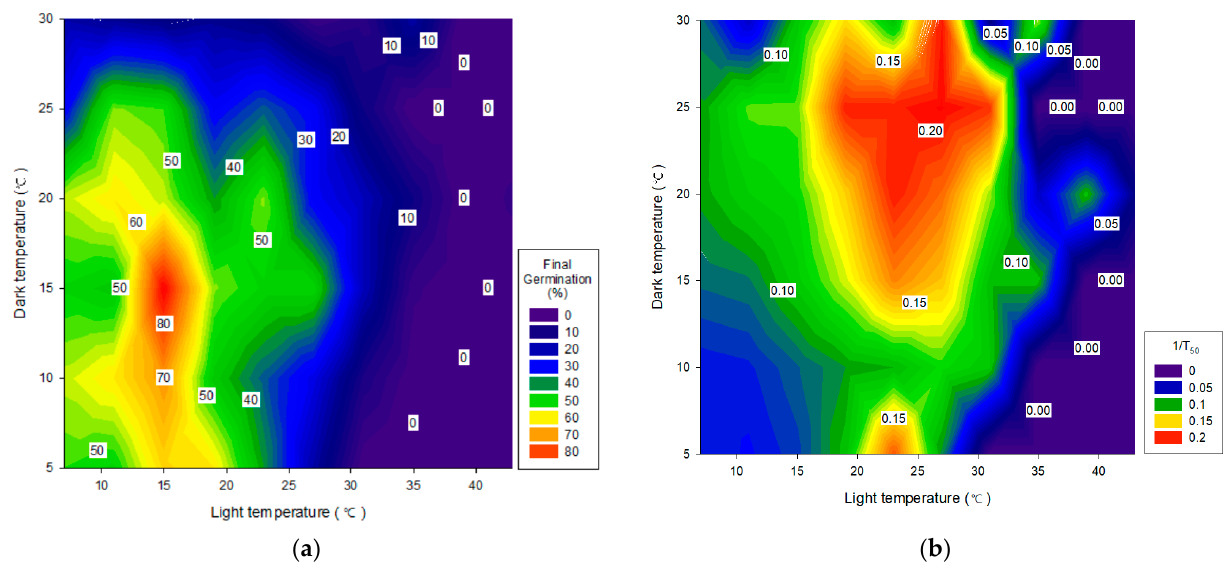
Figure 4. Germination response revealed by the analysis of FGP and the inverse of the number of days required to reach 50% of the FGP (1/T 50 ) of the seeds exposed to alternating temperature regimes using a thermal gradient plate: ( a ) FGP (%) at different temperatures; ( b ) 1/T 50 at different temperatures ranging from 5 °C to 43 °C.